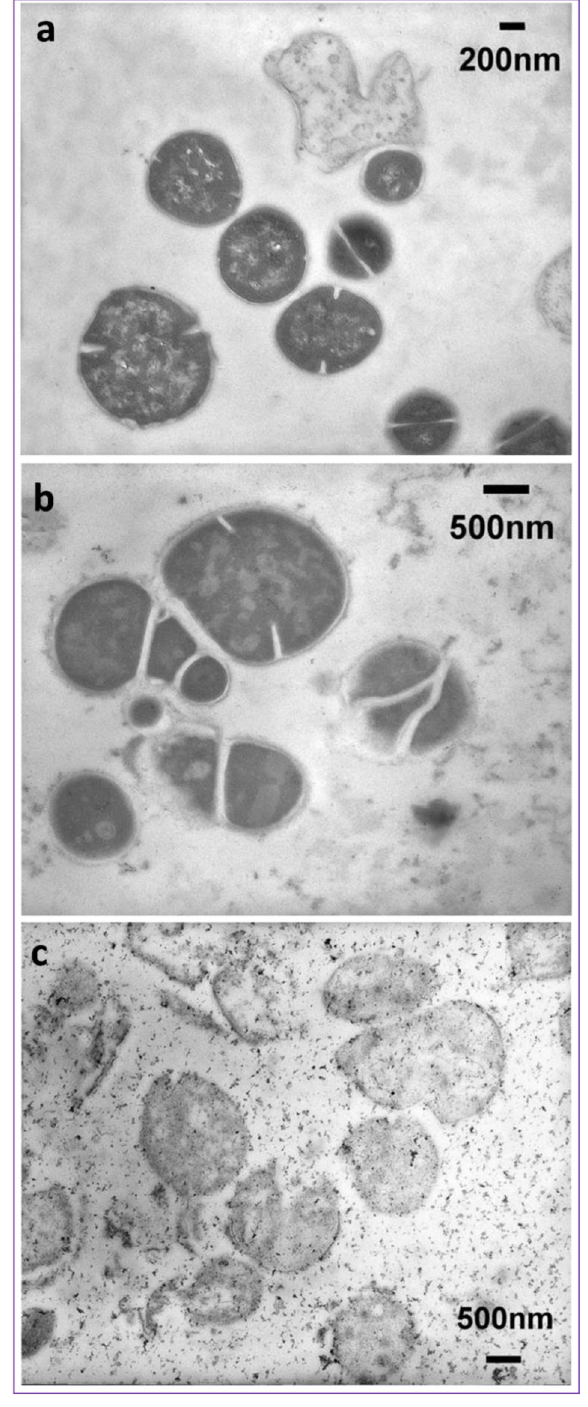
Fig. 5 Representative transmission electron micrographs of MRSA USA300 cells. a Untreated MRSA USA300 cells. b HG2-treated (3x MIC for 1 h) MRSA USA300 cells. c HG4-treated (3x MIC for 1 h) MRSA USA300 cells. Scale bars are 200 or 500 nm as shown on